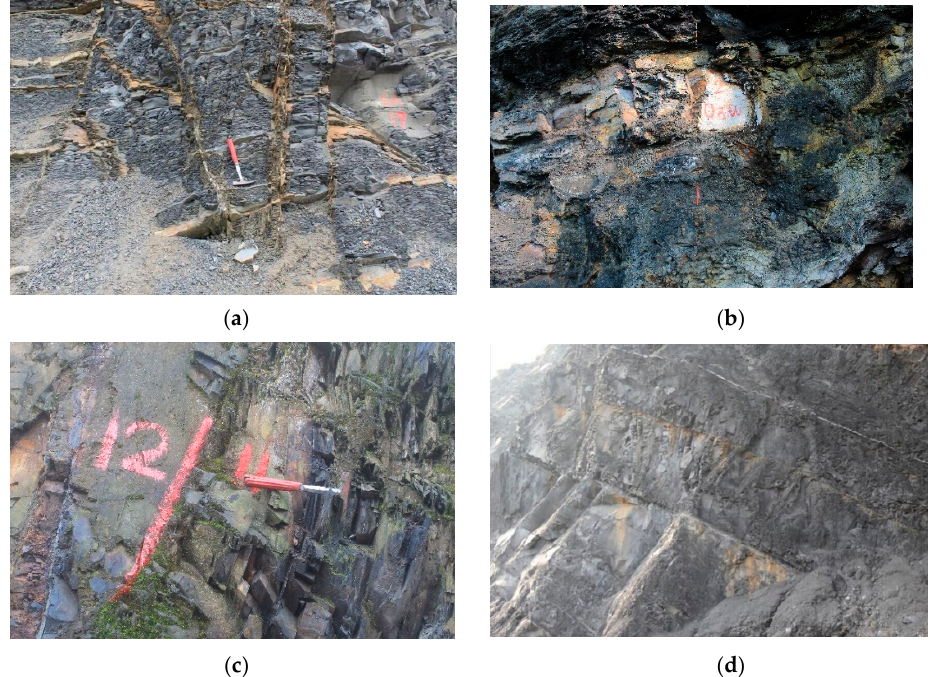
Figure 1. Four kinds of typical shale outcrops where calcite filled with high angle natural fractures were found. ( a ) High-angle fractures filled with calcite in the Longmaxi Formation, Xishui. ( b ) High-angle joints filled with calcite in rupture surface of the Wufeng Formation, Qijiang. ( c ) High-angle fractures in the Longmaxi Formation, Wansheng. ( d ) Longmaxi Formation horizontal joints fully filled with calcite, Changning.